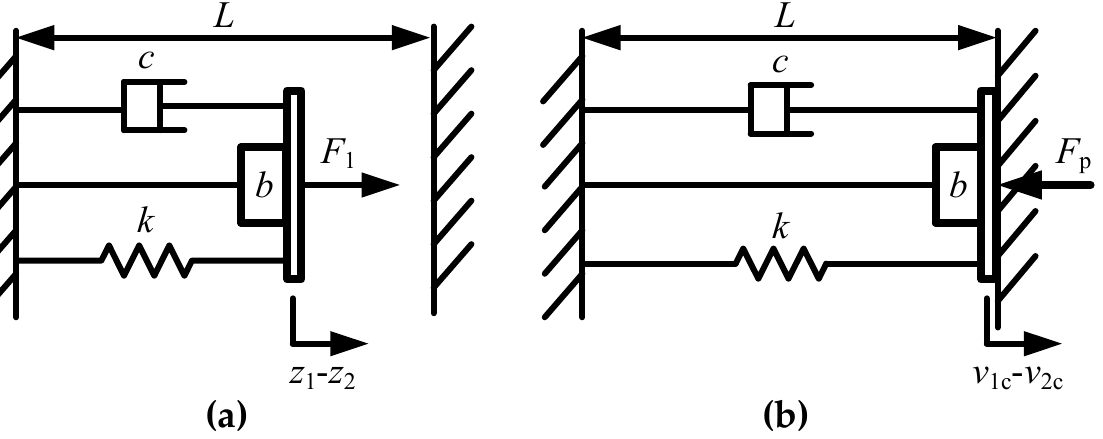
Figure 2. Dynamic model of the DBoI in a typical ISD system. ( a ) Before dynamic-breakdown; ( b ) During dynamic-breakdown.